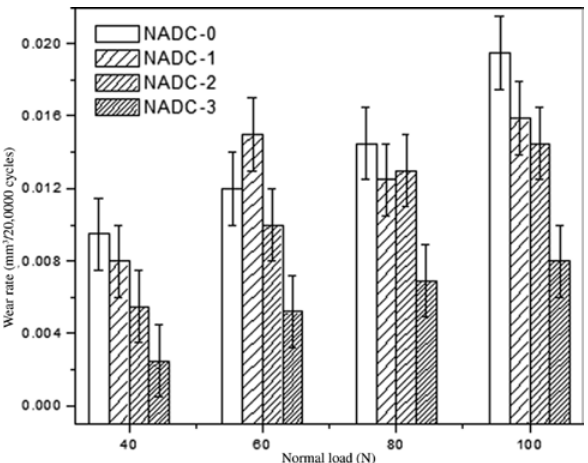
Figure 4: Effect of normal load on volumetric wear rate of the dental composites in distilled water condition (at constant chewing speed of 5 mm/s and chamber temperature of 25 ° C).